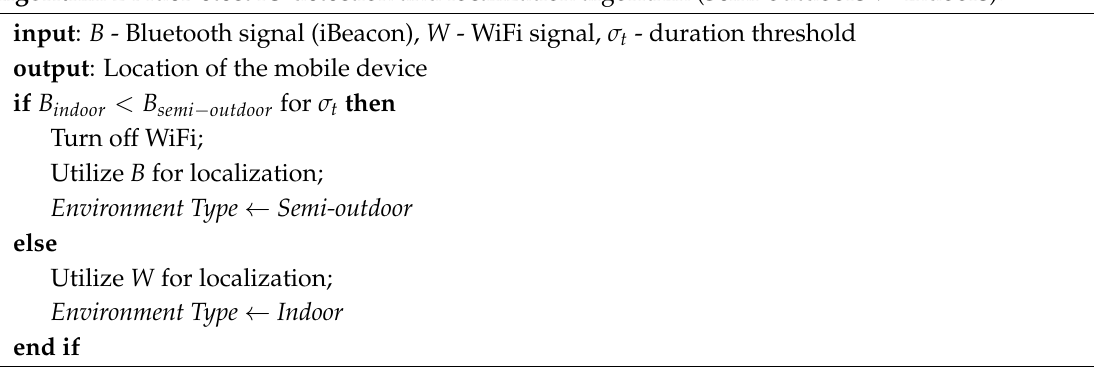
Algorithm 2 BlueDetect IO detection and localization algorithm (Semi-outdoors (cid:10)